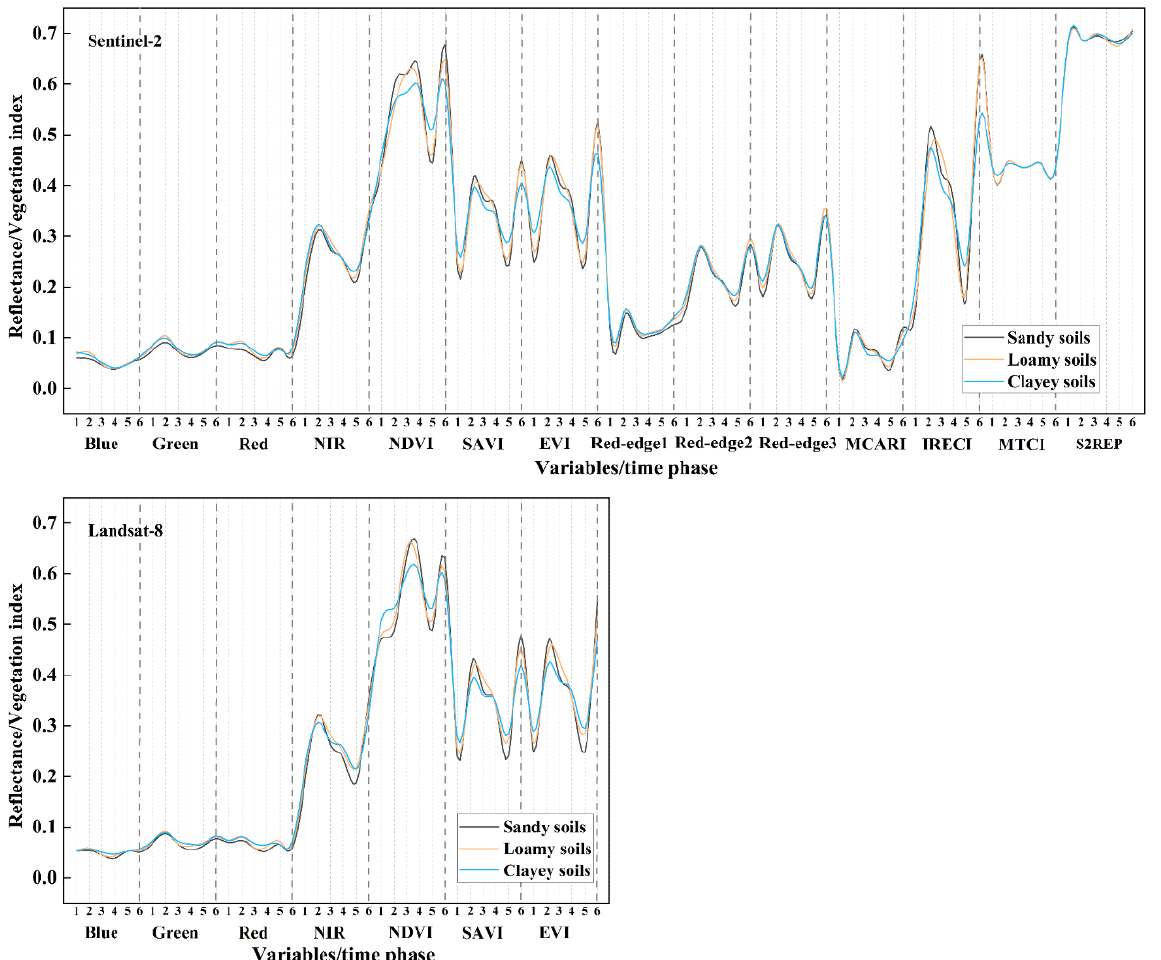
Figure 5. Spectral reflectance and vegetation indices from Sentinel-2 and Landsat-8 change with soil texture classes (the numbers 1–6 in the horizontal coordinates denote six different time phases, which are in the following order: (1) 12 December 2017; (2) 26 April 2019 or 2 May 2019; (3) 23 September 2019; (4) 11 November 2020; (5) 28 February 2022 or 4 March 2021; (6) 3 August 2021. The values of MTCI and S2REP were not in the range (0,1) and they were processed by min-max